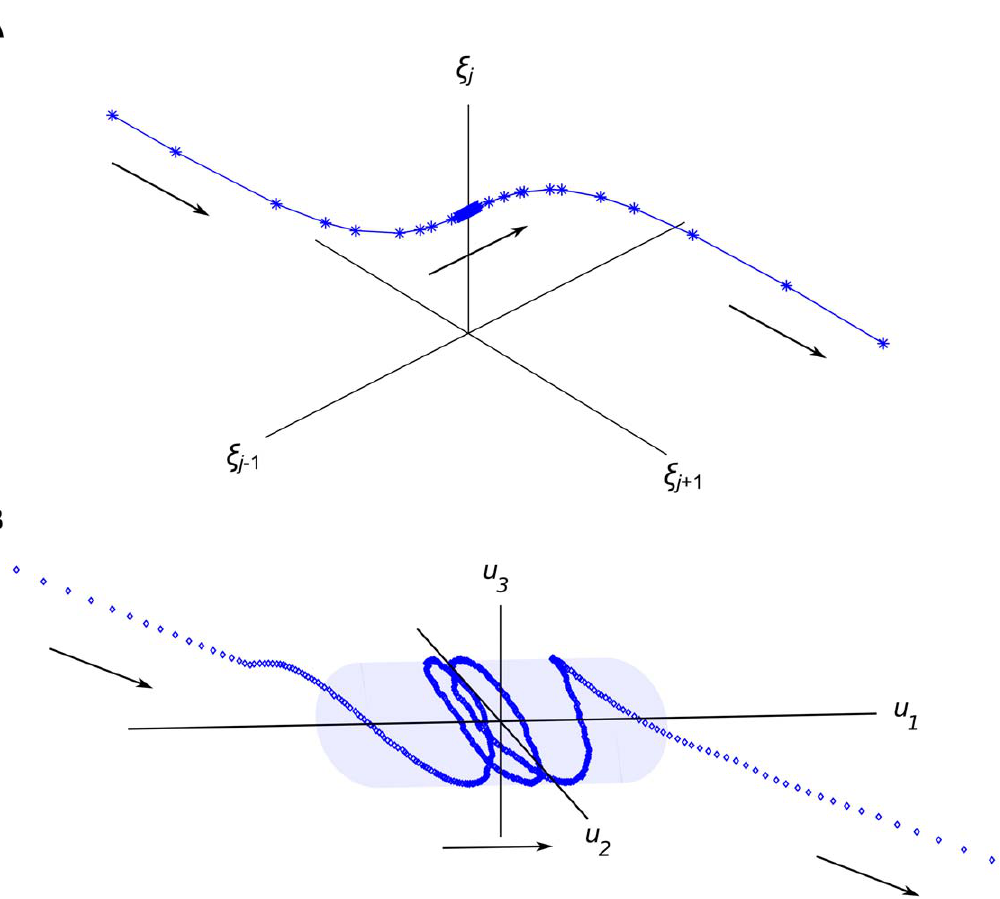
Figure 1. Multiscale dynamics: slow operational signal and SFM emergence. Panel A: The slow operational signals { j j } converge through a fast transient to a specific j j node resulting (here) in the emergence of a cylindrical manifold. Panel B: The functional dynamics { u i } collapses fast (also) onto the manifold where it executes a slow spiral flow. The j j node’s stability is sustained for the duration of the flow execution. Subsequently, the j j node destabilizes, followed by the related manifold and the dynamics moves away, again through fast transients. The density of data point is inversely proportional to the time scale of the dynamics.